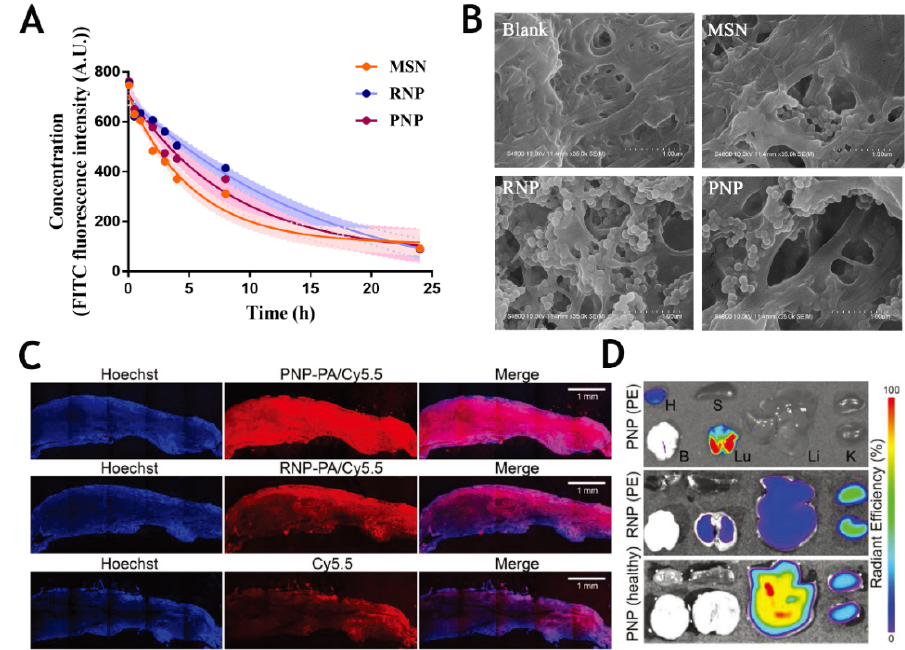
Figure 5. ( A ) The blood circulation time of the three nanoparticles (MSN/PNP/RNP) proved that the coating of erythrocyte membrane and platelet membrane can prolong the blood circulation time of the nanoparticles to varying degrees. ( B ) RBC membrane (RNP) and platelet membrane (PNP) coated nanoparticles have different degrees of affinity for fibrin. Reprinted with permission from [75]. Copyright (2020) American Chemical Society. ( C ) Confocal images of patient thrombi. Nuclei were stained with Hoechst 33342 (blue), PNP-PA and RNP-PA were labeled with Cy5.5 (red). ( D ) Cy5.5- labeled nanoparticle (RNP/PNP) was significantly enriched in the lung of the PE model. H, heart; B, brain; S, spleen; Lu, lung; Li, liver; K, kidney. Reproduced with permission [76]. Copyright 2020,